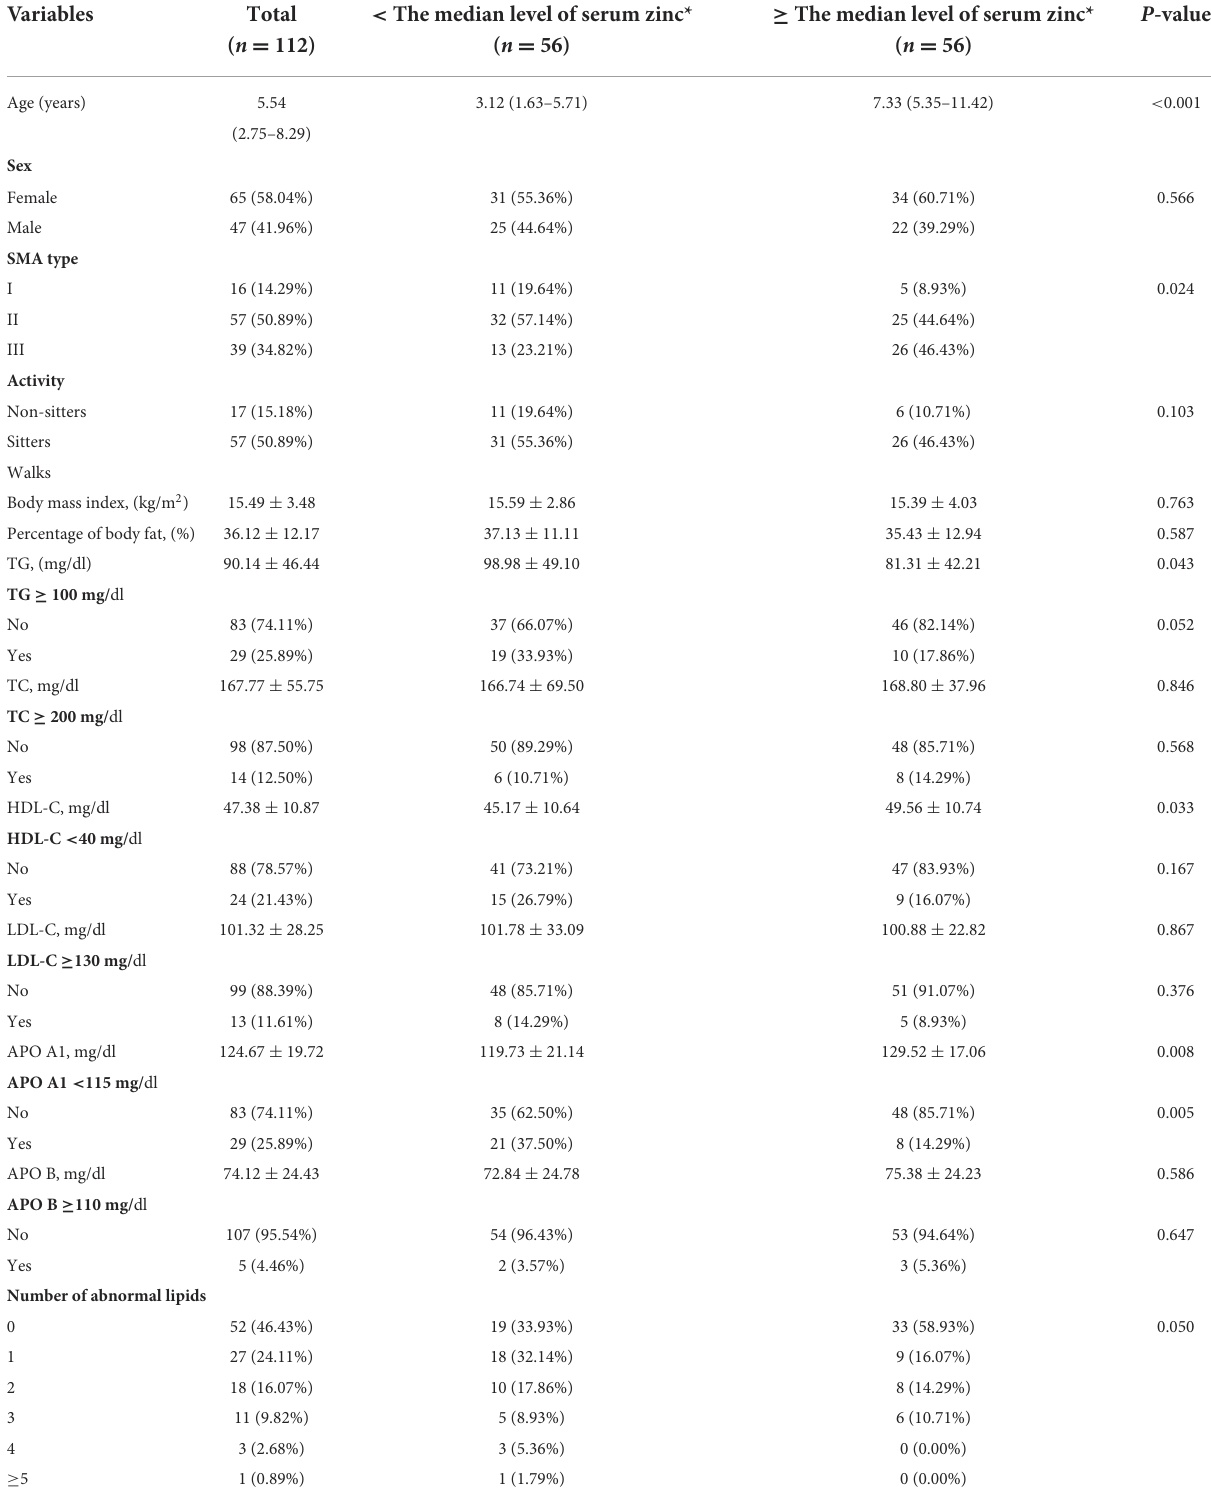
TABLE 1 Baseline characteristics of the study participants by the median level of serum